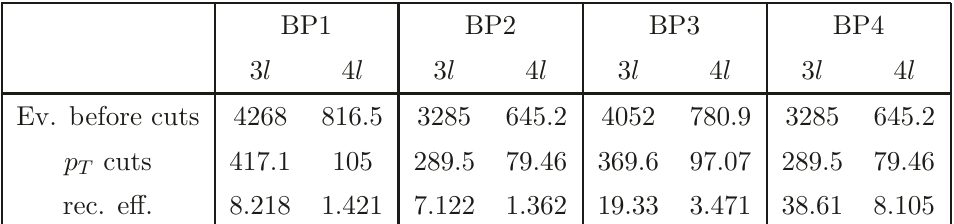
H 1 ν h ν h ) multiplied → →